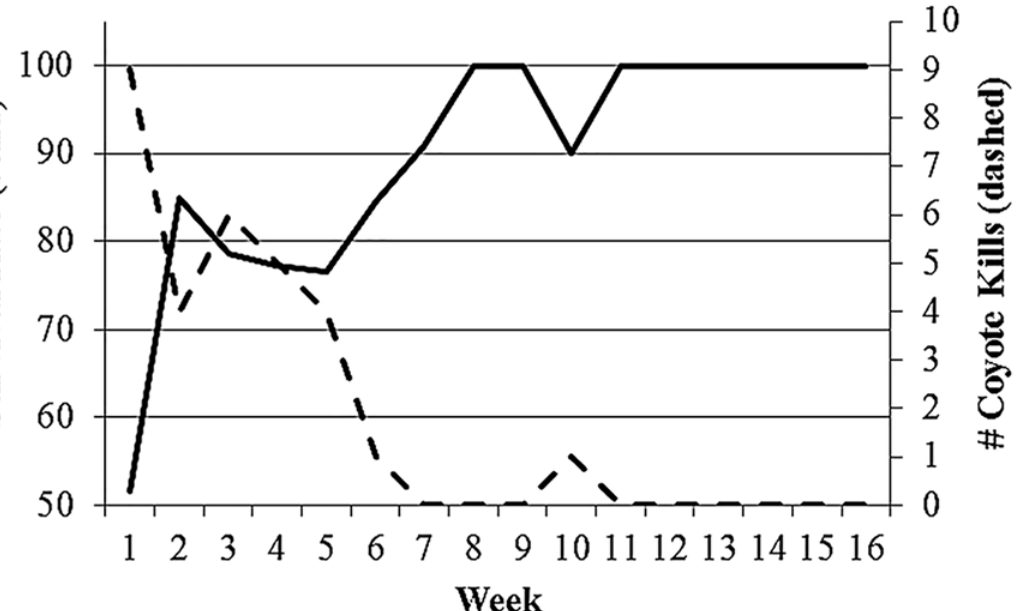
Fig 1. Weekly survival estimates for radiocollared neonatal white-tailed deer (solid line) and number of coyote kills per week (dashed line) at Fort Bragg Military Installation, North Carolina, 2011 – 2012.